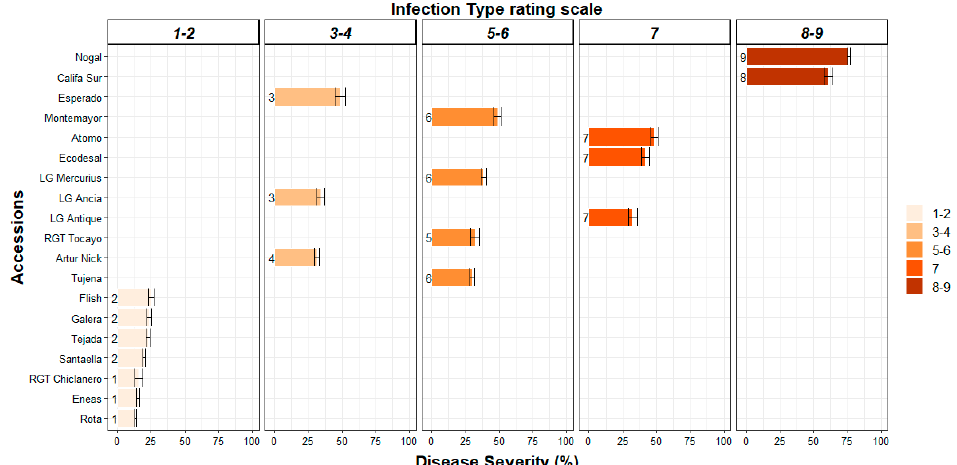
Figure 1. P. striiformis infection in bread wheat accessions. Mean percentage of disease severity (DS), presented in columns, and infection type (IT) rating scale, presented as numbers at the top of the figure. Accessions were arranged according to their mean percentage of DS and classified according to IT in panels. The IT scale is presented according to McNeal et al. [49], where 0 = no visible disease symptoms (immune), 1 = minor chlorotic and necrotic flecks, 2 = chlorotic and necrotic flecks without sporulation, 3–4 = chlorotic and necrotic areas with limited sporulation, 5–6 = chlorotic and necrotic areas with moderate sporulation, 7 = abundant sporulation with moderate chlorosis, 8–9 = abundant and dense sporulation without notable chlorosis and necrosis. Error bars represent the standard error calculated from three independent experiments with six replicates